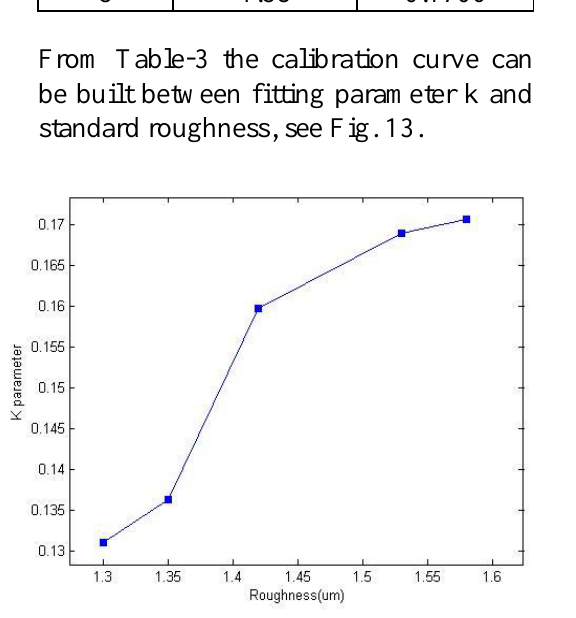
Fig. 13: The relationship between standard roughness values as a function of fitting parameter (k).